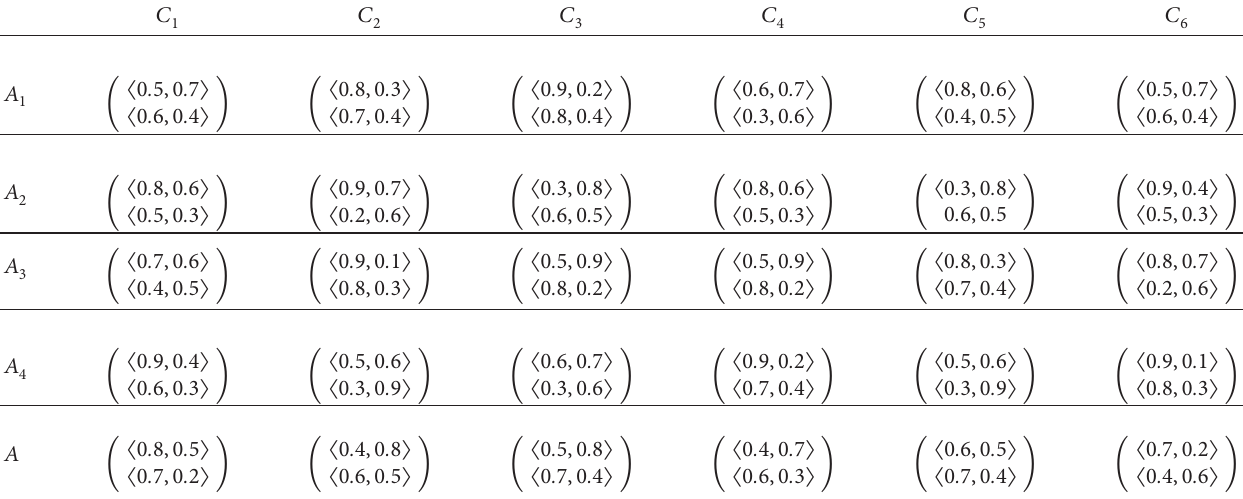
Table 1: The q -RLDFNs’ information given by the expert.